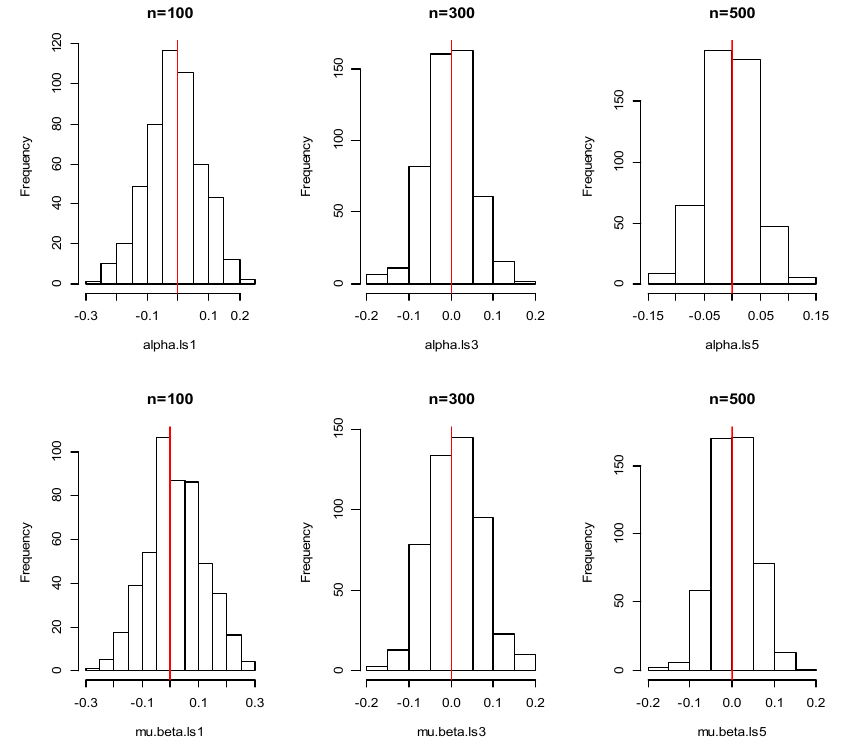
α μ α and µ β with the least-squares method in Case and β with the least-squares method in Case 2. Figure 5. Histogram of estimated parameter α μ and β with the least-squares method in Case 2.